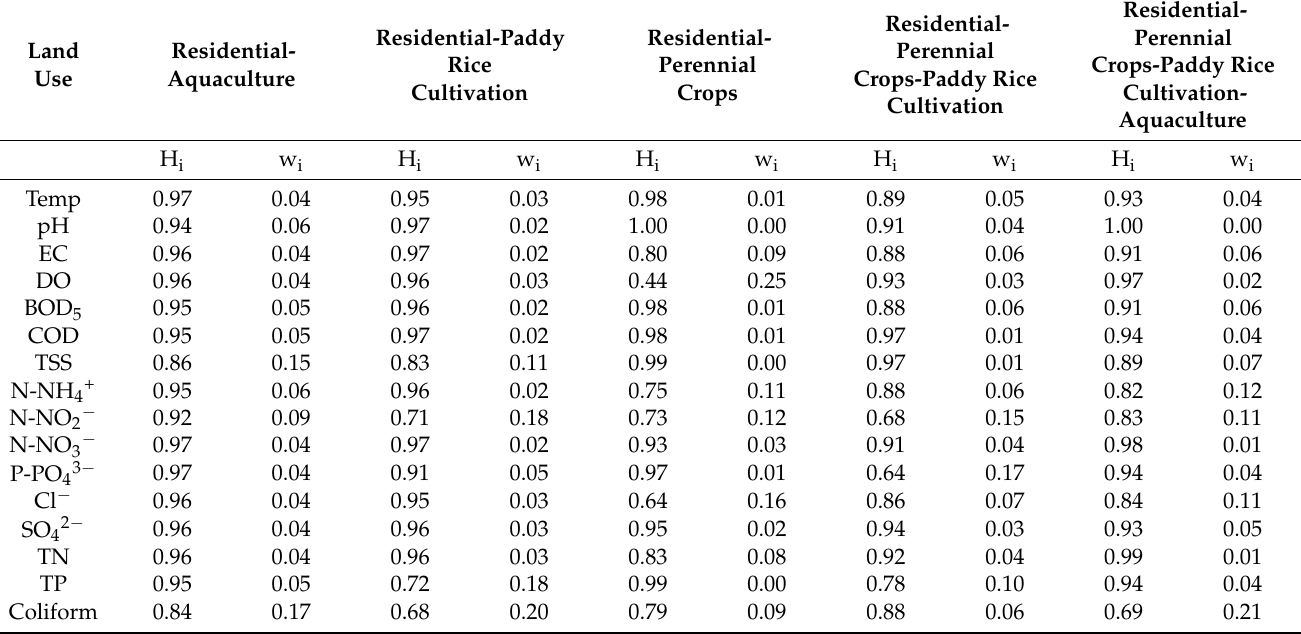
Table 4. Entropy weights of water quality parameters for different land use